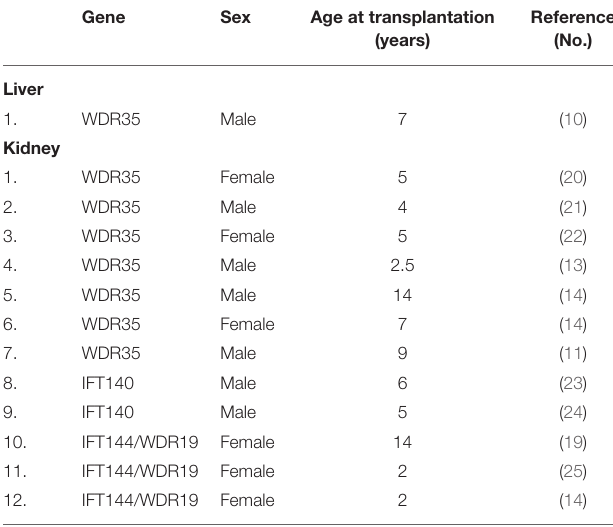
TABLE 2 | Liver and kidney transplantation in Sensenbrenner syndrome. Gene Age at transplantation